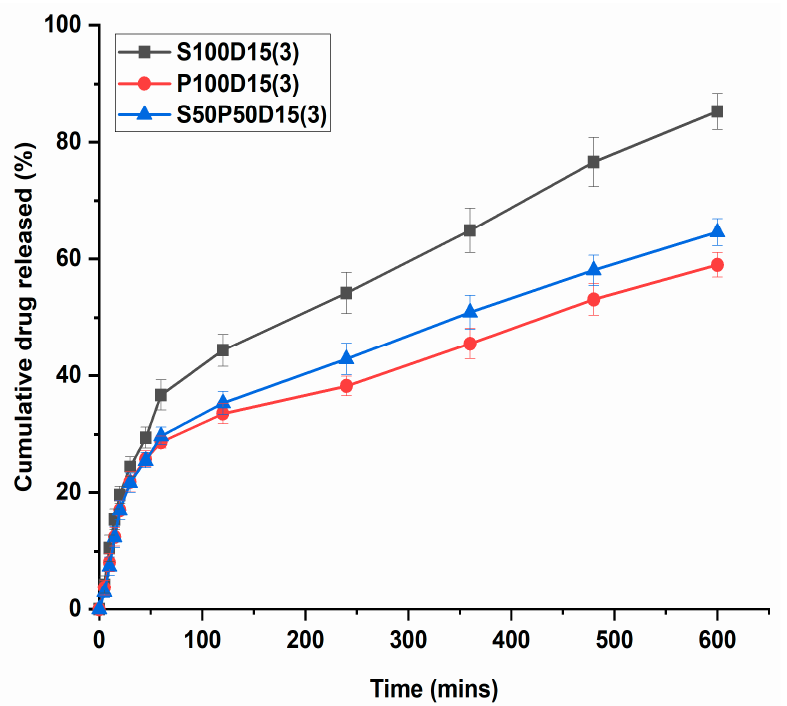
Figure 8. In vitro drug release behavior from drug-loaded SA/PVA-MMT clay-reinforced nanocom- posite films at pH 6.8 in 1× PBS.